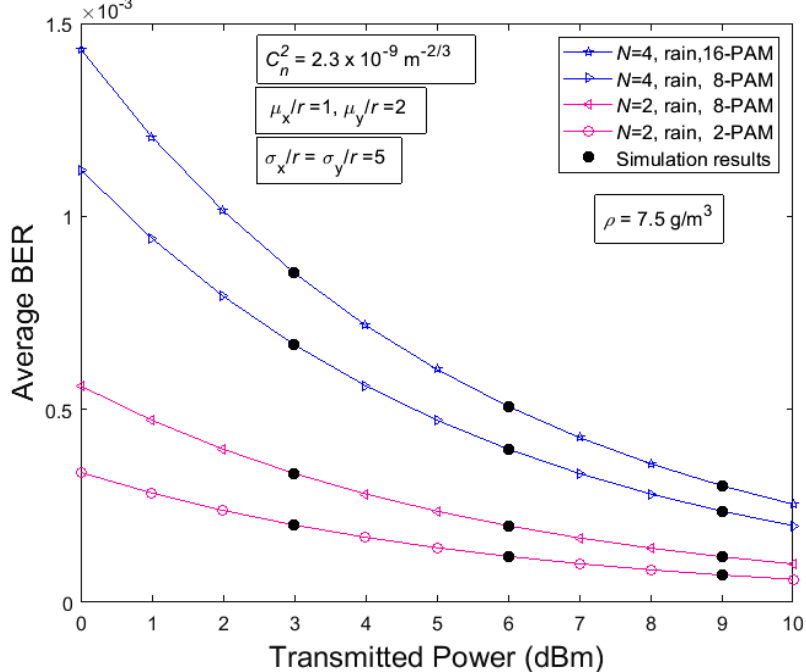
Figure 6. ABER vs. transmitted power for dual-hop and quad-hop THz link configurations with 2-, 8- or 16-PAM modulation formats under strong turbulence, rain, moderate water vapor concentra- tion and weak NZB pointing